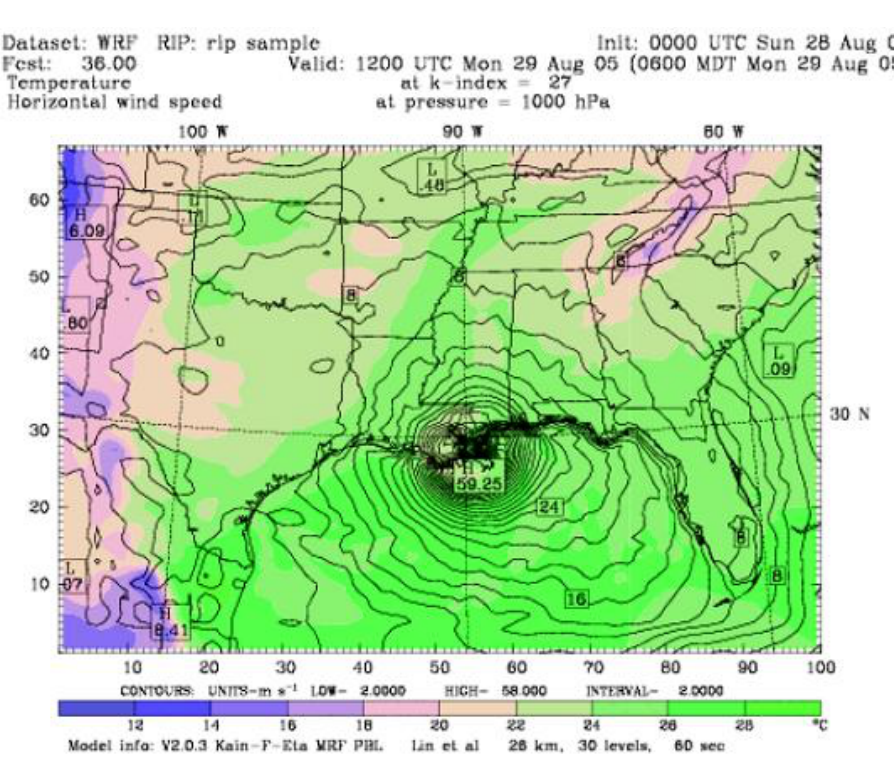
Figure 8. Modeling simulations of Wind Velocity of hurricane Katrina with a peak intensity of 59 m/s (175 mph), at the time of Land Fall on 28 August 2005.